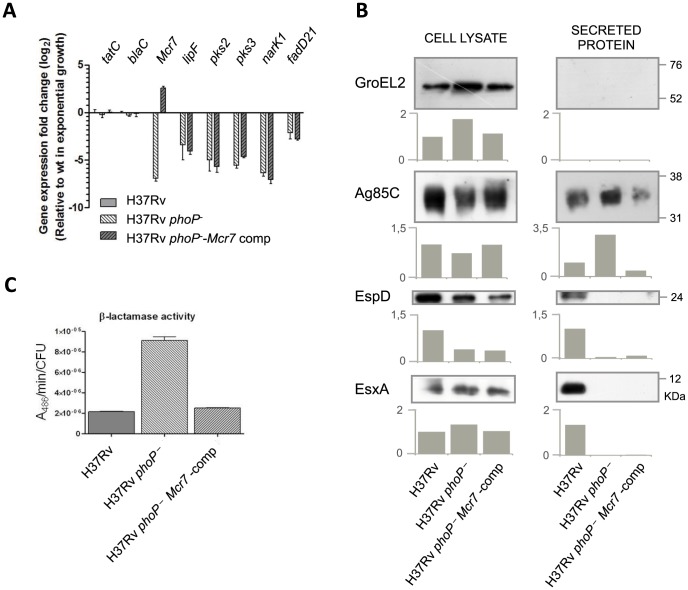
Reintroduction of mcr7 in an M. tuberculosis phoP mutant restores secretion of Tat-dependent substrates to wild type levels.
A. qRT-PCR analysis of tatC, mcr7 and other genes from the PhoP regulon (lipF, pks2, pks3, narK1 and fadD21). Bars represent fold changes in the expression levels in the phoP mutant and mcr7-complemented strains relative to M. tuberculosis wild type grown exponentially in 7H9 medium. Expression of the tatC mRNA is independent of phoP mutation and mcr7 expression. Note that complementation with mcr7 does not affect expression of the PhoP regulon. Results are representative of three independent experiments and error bars are the standard deviation of the mean. B. Western blot experiments of GroEL2, Ag85C, EspD and EsxA in the whole cell and secreted fractions of M. tuberculosis wild type, its phoP mutant and the mcr7-complemented strains. Equal protein amounts were loaded per well. GroEL2 is used as a control of bacterial integrity in each sample. Signal intensity was quantified and plotted in the graphs below the Western blot images. Results are representative of three independent experiments. C. Measure of β-lactamase activity of the BlaC protein by nitrocefin chromogenic assay. Activity is calculated relative to the CFU/ml in each strain.